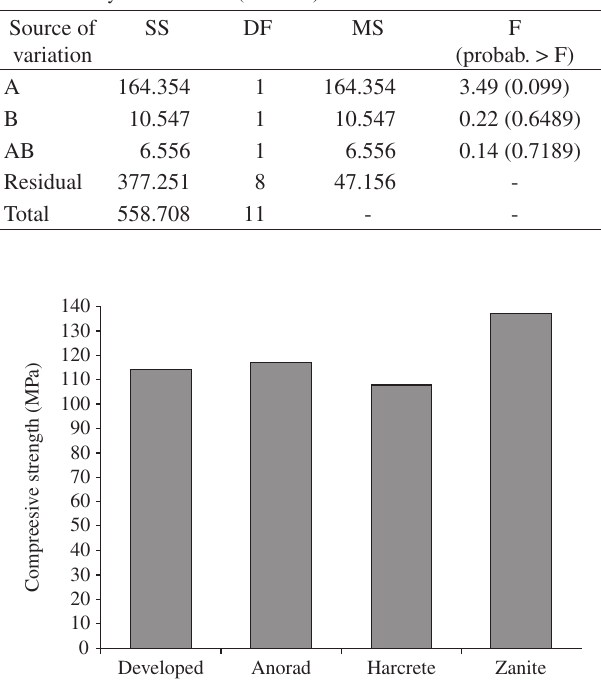
Figure 1. Compressive strength comparative values of some granite-epoxy composites.